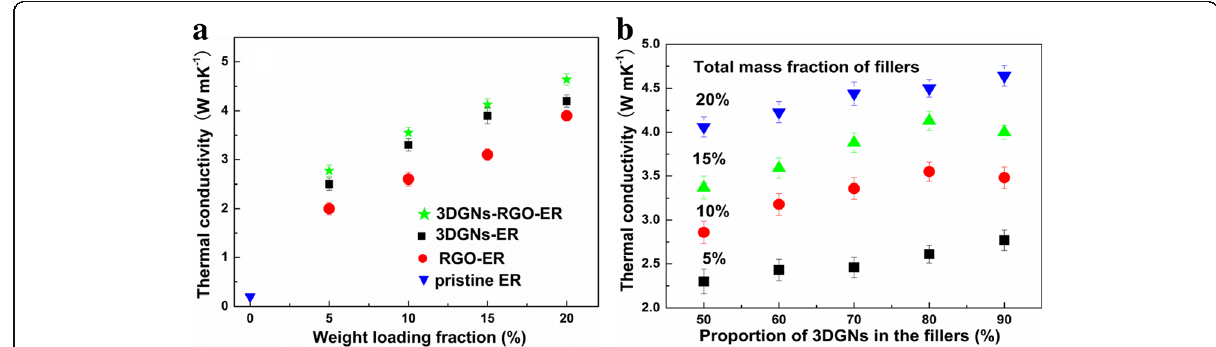
Fig. 3 Thermal conductivities of resulting composites with increased mass factions of fillers. The corresponding thermal performances of various samples are shown in Fig. 3. The thermal conductivity of the pristine ER is 0.2 W/mK, which is far from the requirement for the TIMs. With the increased mass fractions of various fillers, the resulting thermal performances enhance almost in a linearly manner ( a ). Therein, the RGO nanosheets and 3DGNs co-modified composites display the best performance with identical mass fraction compared with these cases of employing a single filler, and the specific thermal conductivity value is closely related to the proportion of the 3DGNs and RGO nanosheets, demonstrating a synergy between them ( b ). Although both the RGO nanosheets and 3DGNs are constituted with graphene basal sheets, the distinctions from morphology of these two fillers and chemical state of carbon atoms endow the different functions of them in the TIMs. On the one hand, the high quality and the continuous structure of the 3DGNs make it an excellent fast transport network for phonons, which has been proven in our previous reports. On the other hand, due to the high defect density and the lack of a continuous structure, the phonon transport ability of the RGO filler is weaker than the